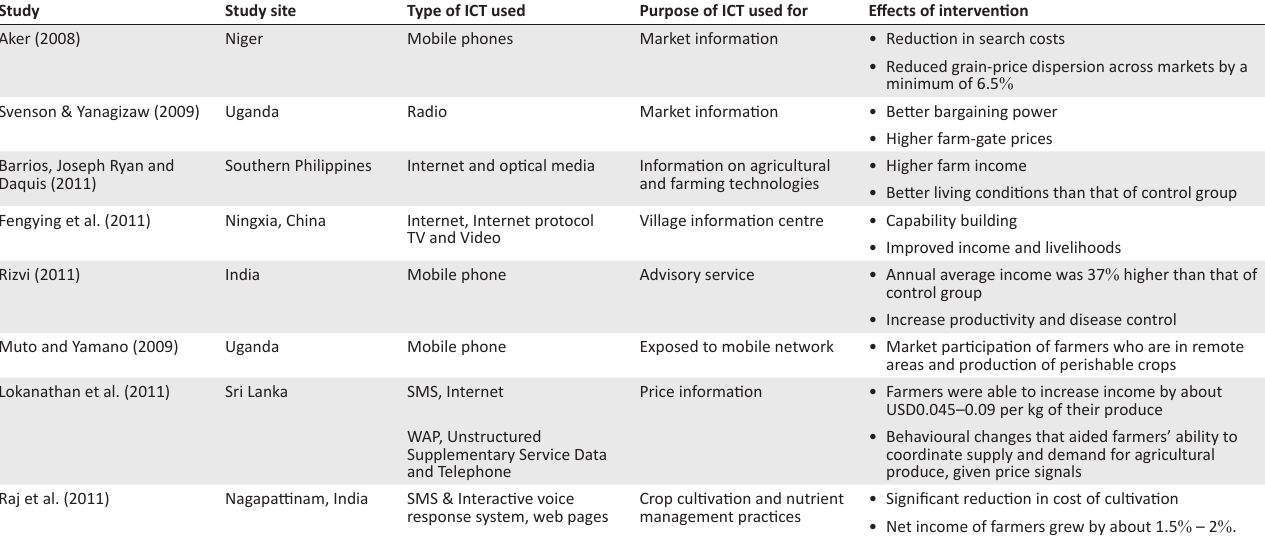
TABLE 1: Selected empirical studies on the impact of mobile (information and communication) technology on agriculture.